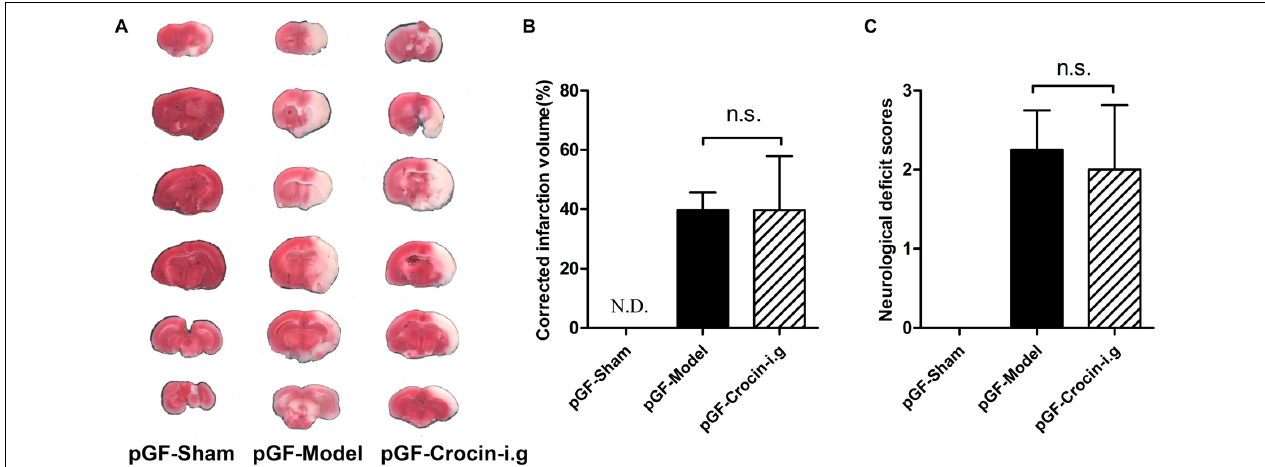
FIGURE 5 | The effect of orally administered crocin on cerebral I/R injury in pGF rats. Representative images of the same brain stained with TTC (A) , average infarction volumes corrected for brain edema as indicated (B) , and neurological deficit scores in each group (C) are shown after orally administered crocin in pGF rats. Data are represented as the mean ± SD ( n = 6), N.D., infarction not detected.